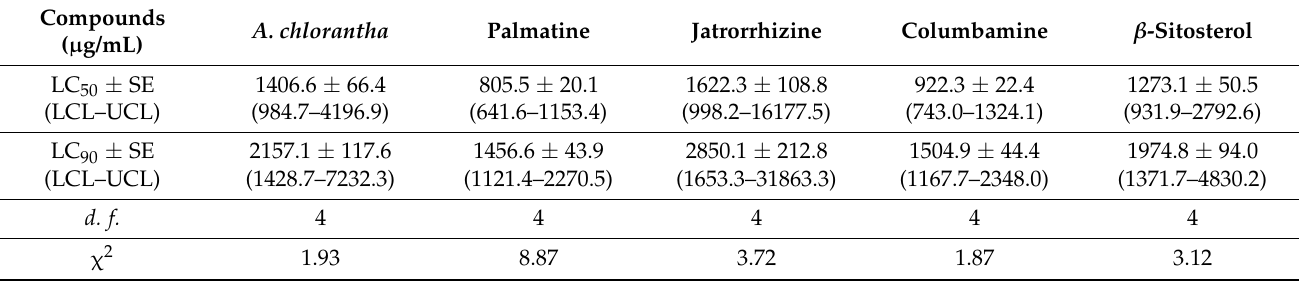
Table 3. Toxicity of the palmatine, jatrorrhizine, columbamine, β -sitosterol, and Annickia chlorantha extract (AC) to the zebrafish ( Danio rerio ), 96-h